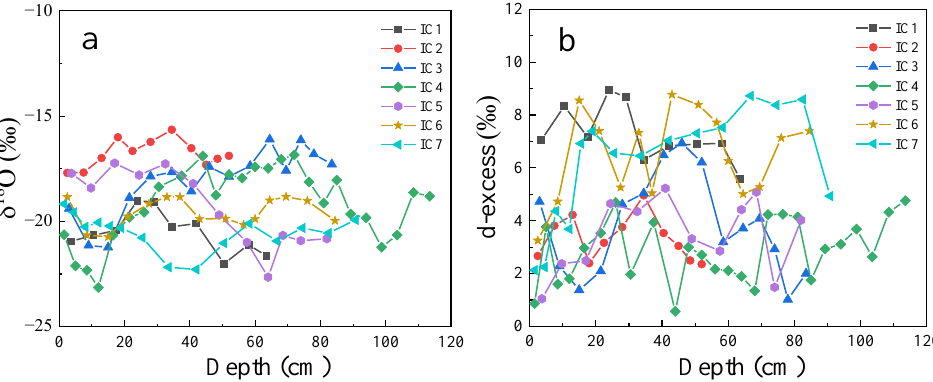
Figure 7. ( a ) Variations of δ 18 O with depth of IC ice cores; ( b ) variations of d-excess with depth of IC ice